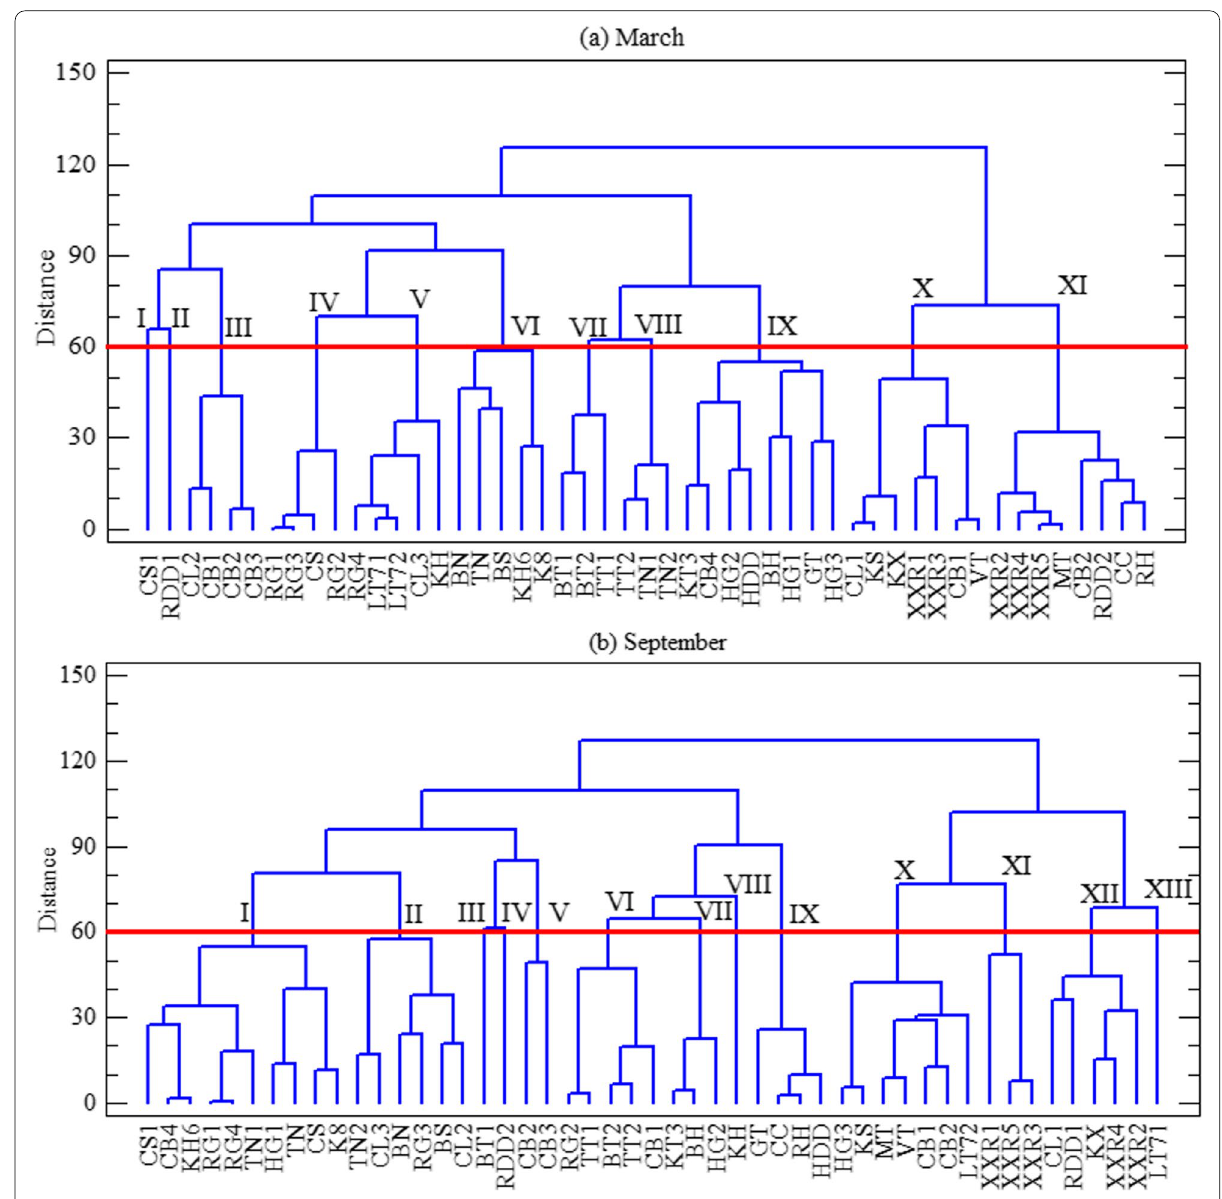
Fig. 5 Hierarchical dendrogram of sampling locations in ( a ) the dry season and ( b ) the rainy